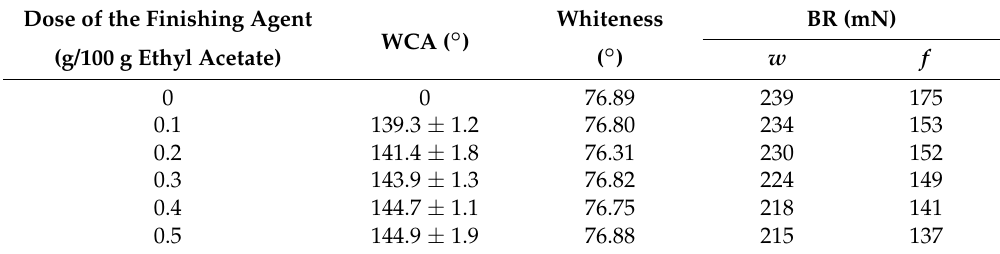
Table 2. Performance properties of the cotton fabrics treated with PFAS. Dose of the Finishing Agent Whiteness BR (mN) WCA ( ◦ ) ( ◦